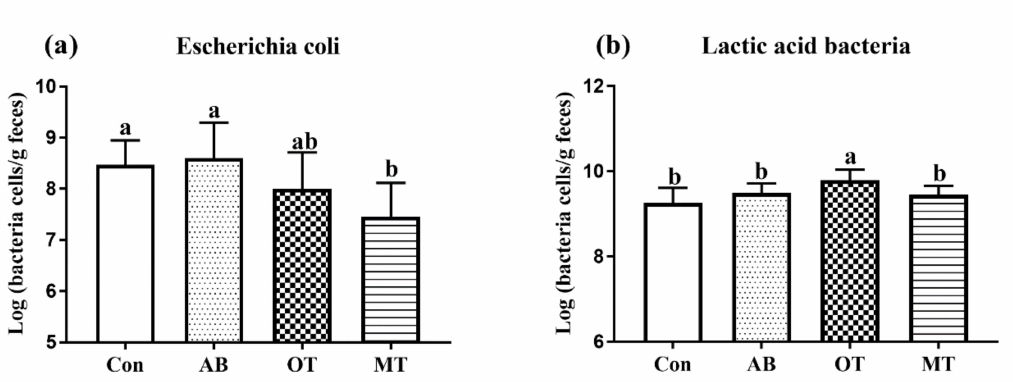
Figure 2. Counting of Escherichia coli and lactic acid bacteria in fresh feces of piglets. ( a ) Escherichia coli . ( b ) Lactic acid bacteria. Con, the basal diet without antibiotics, tributyrin, oregano or methyl salicylate; AB diet, the basal diets supplemented with an antibiotic compound, which provides the diet with 120 mg oxytetracycline-calcium and 16 mg enduracidin per kilogram; OT and MT diets, the basal diet supplemented with tributyrin plus oregano (1.4 g and 0.6 g per kilogram diet) and tributyrin plus methyl salicylate (1.4 g and 0.6 g per kilogram diet), respectively. One gram of the sample was weighed and diluted to a dilution of 10 − 6 , 10 − 7 , 10 − 8 by a 10-fold gradient dilution method. They were coated on EMB and MRS identification media for identification of Escherichia coli and lactic acid bacteria. Colony count = number of original bacterial colonies × dilution factor × 100 CFU / mL. a,b Means without a common superscript letter di ff er ( p < 0.05) ( n =